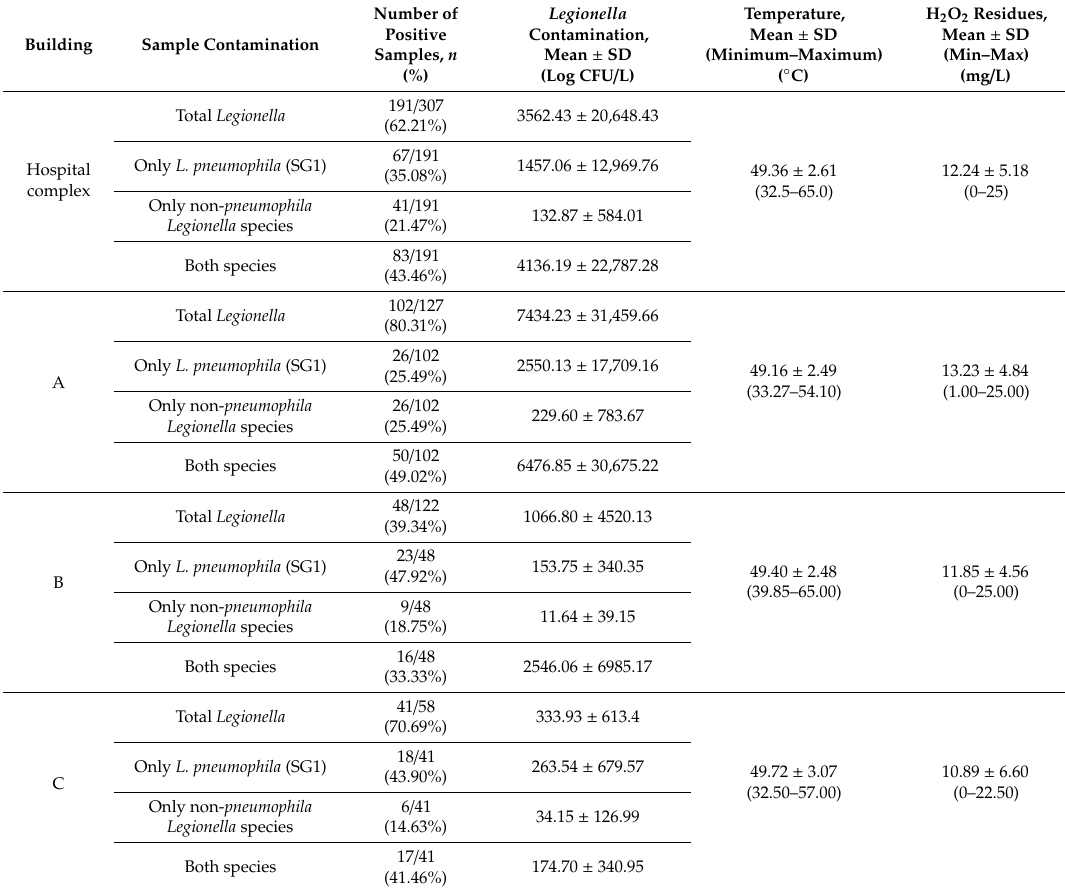
Table 4. Isolate distribution between buildings and physical–chemical parameters